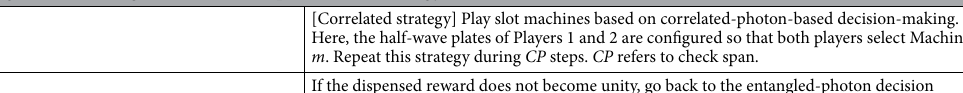
Figure 2. Reward environments and collective decision-making strategies. ( a ) Usually, the reward gained by a single player is half a unit reward, if the decision is conflicted. ( b ) During the happy hour, the higher-reward probability machine yields unit reward to both the players, even if the decision is conflicted. ( c ) In the mixed strategy, while entangled photons are used most of the time, correlated photons are occasionally used (denoted by search interval) during certain duration (check span) to check if greedy action is more Algorithm 1: Entangled and correlated-photon mixed strategy